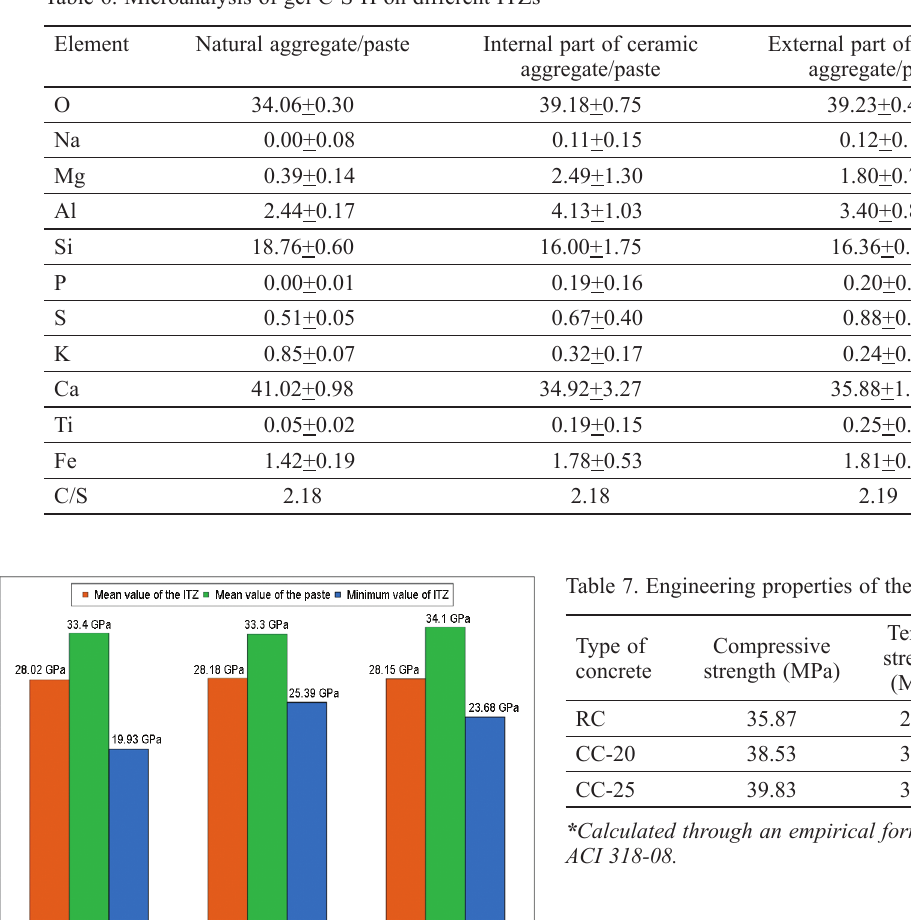
Table 6. Microanalysis of gel C-S-H on different ITZs